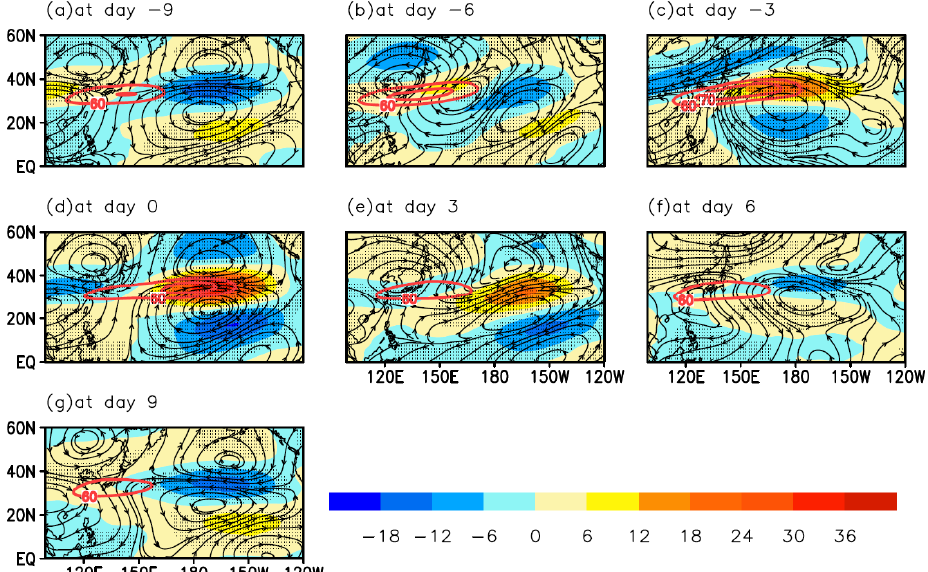
Figure 3. Composite of the intraseasonal zonal wind (color shade, unit: m/s), the intraseasonal air flow (stream line), and the zonal wind (only ≥ 60 m/s are shown, the red line, unit: m/s) at 200 hPa from day − 9 to day 9 ( a – g ), with an interval of 3 days. The dotted area indicates that the intraseasonal zonal wind anomaly at 200 hPa passed the t-test with 95% confidence.